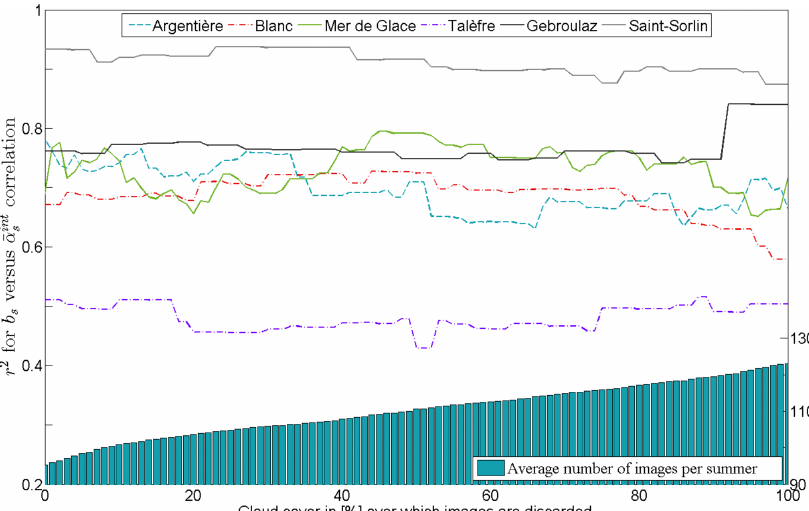
Figure 8. The r 2 for the six seasonally surveyed glaciers for the albedo summer integral vs. summer SMB relationship against the cloud threshold above which images have been discarded during the summer season. For the computation, 100 thresholds have been tested be- tween 0 and 100%. The inner histogram illustrates the number of considered images per summer and averaged on the six